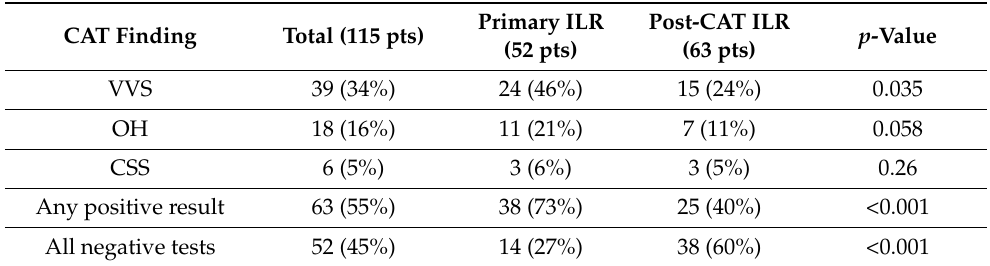
Table 3. Cardiovascular autonomic test (CAT) findings in patients with implantable loop recorder received before and after CAT.